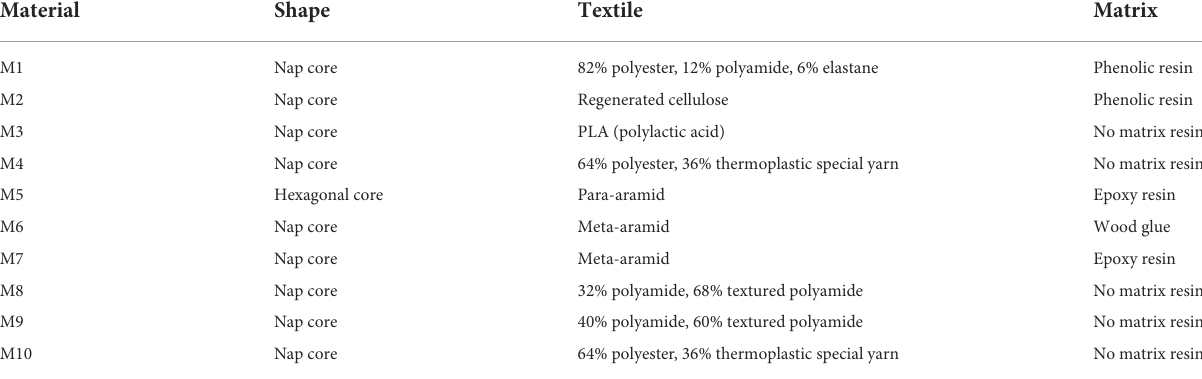
TABLE 1 Overview of the 10 different materials applied in organism tests.